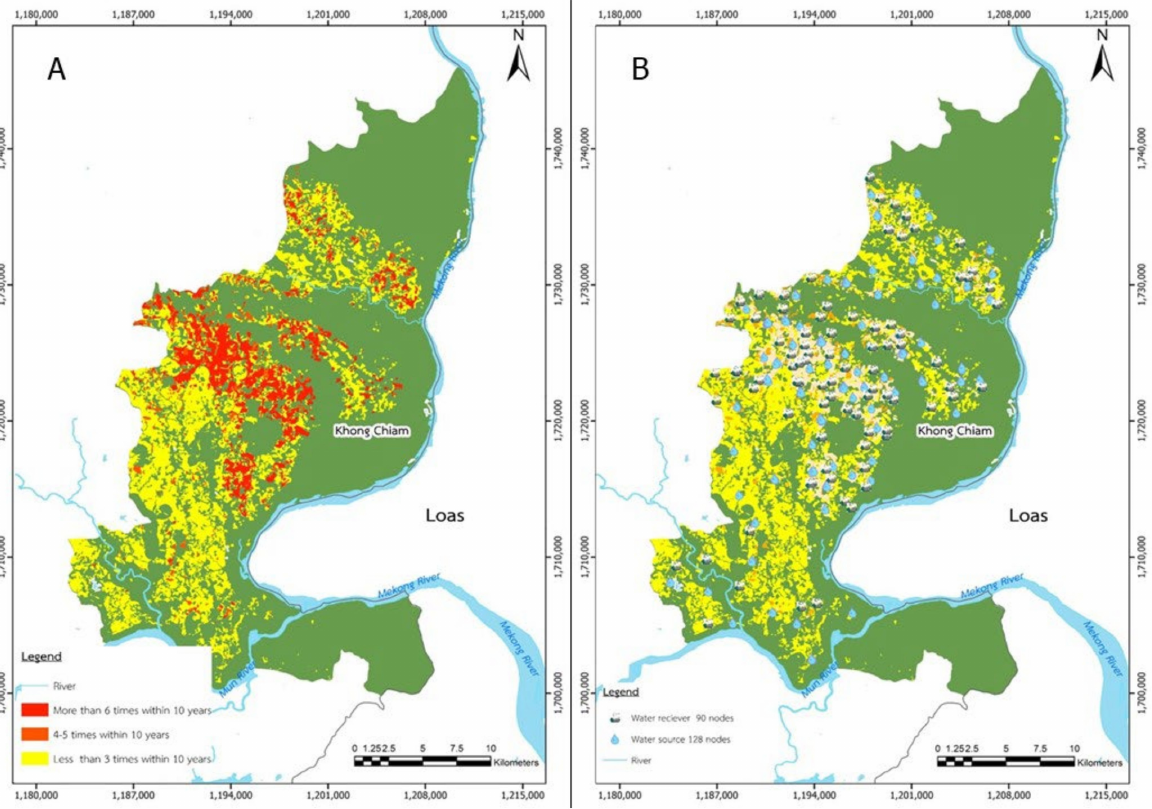
Figure 5. Comparison of drought risk in Khong Chiam ( A ) before and ( B ) after CR